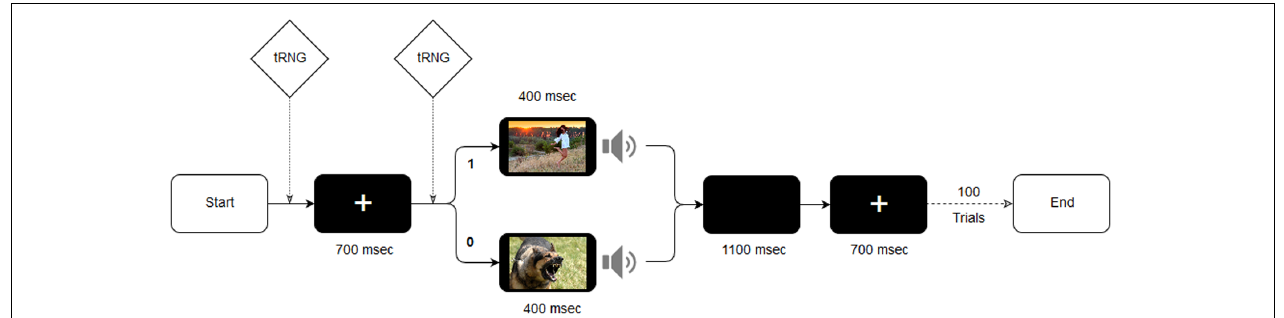
FIGURE 1 | Stimulus selections and presentation times during one